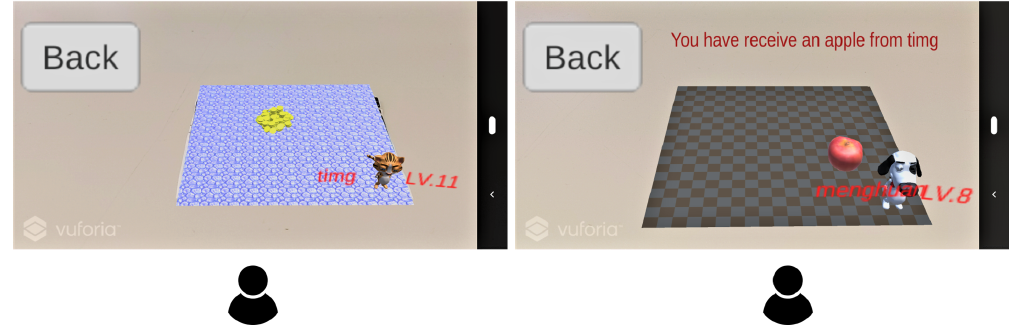
Figure 5. Non-competitive interaction interface. User timg gave an apple to user